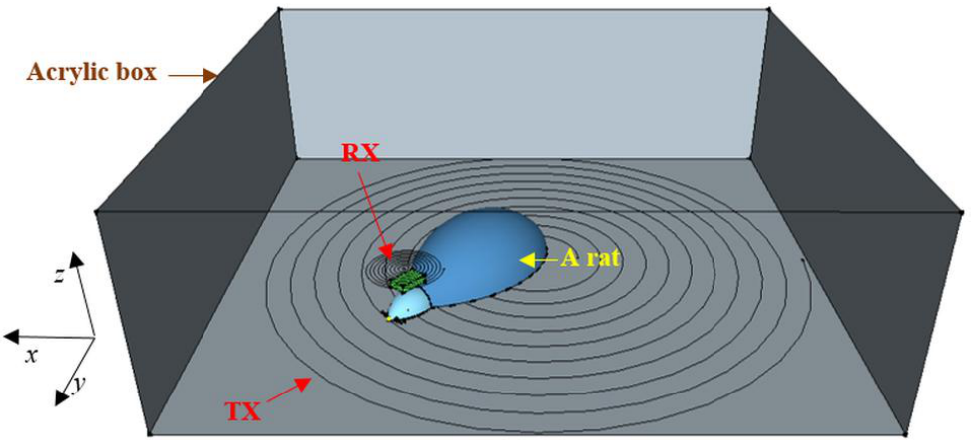
Figure 4. Illustration of the experiment setup with a freely-moving rat wearing the neurotransmitter sensor module inside an acrylic box with a dimension of 40 × 40 × 15 cm 3